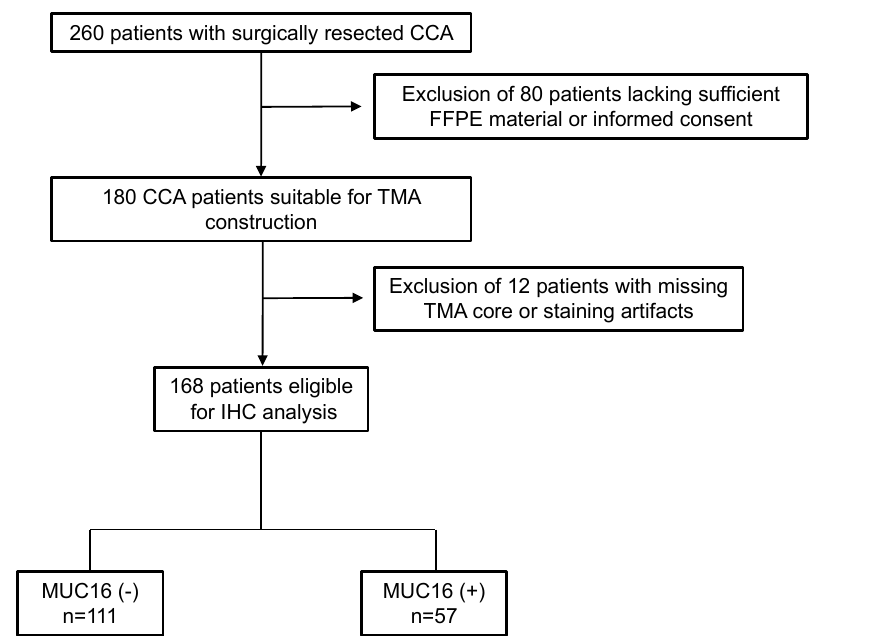
Figure 2. Workflow for screening, enrolment, and allocation. Abbreviations: cholangiocarcinoma